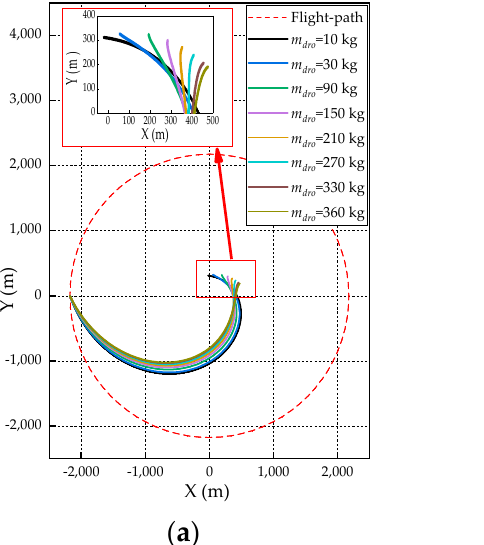
Figure 6. Towline spatial configurations vs. drogue mass: ( a ) Two-dimensional projection in horizon- tal plane. ( b ) Two-dimensional projection in vertical plane.